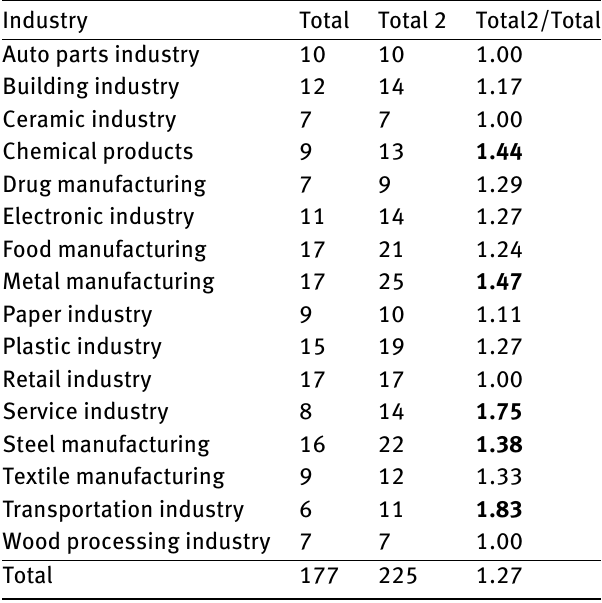
Table 2: Share or “ticked” questionnaire’s